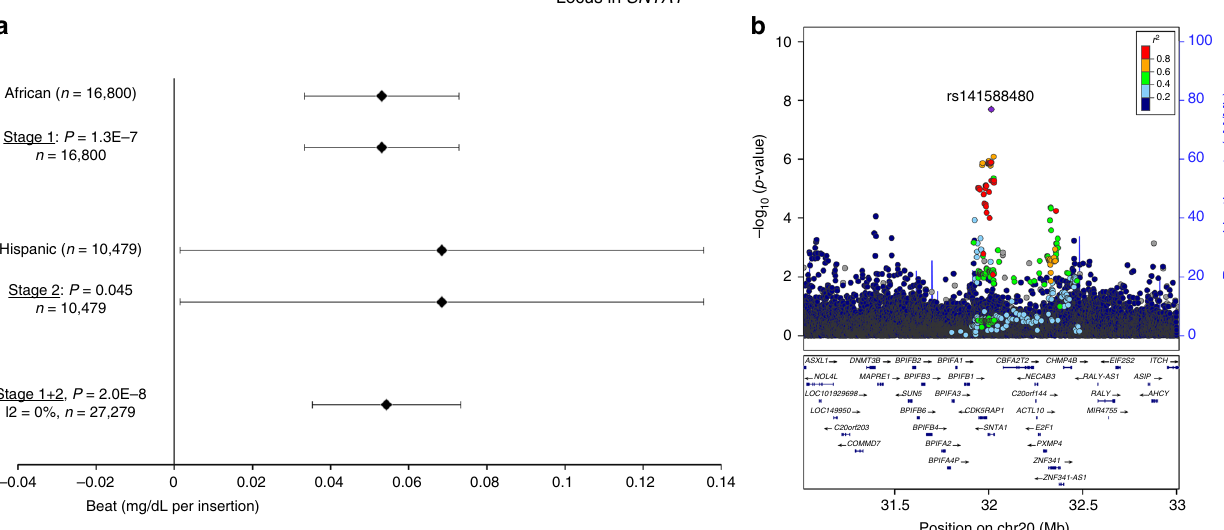
Fig. 4 Interaction of rs141588480 in SNTA1 with physical activity on HDL cholesterol levels. The beta and 95% con fi dence intervals in the forest plot ( a ) is shown for the rs141588480 × physical activity interaction term, i.e., it indicates the increase in logarithmically transformed HDL cholesterol levels in the active group as compared to the inactive group per each insertion of rs141588480. The – log 10 ( p value) in the association plot ( b ) is also shown for the rs141588480 × physical activity interaction term. While the rs141588480 variant was identi fi ed in African-ancestry individuals in Stage 1, the variant did not pass QC fi lters in the Stage 2 African-ancestry cohorts, due to insuf fi cient sample sizes of these cohorts. The P values are two-sided and were obtained by a meta-analysis of linear regression model results. The fi gure was generated using LocusZoom